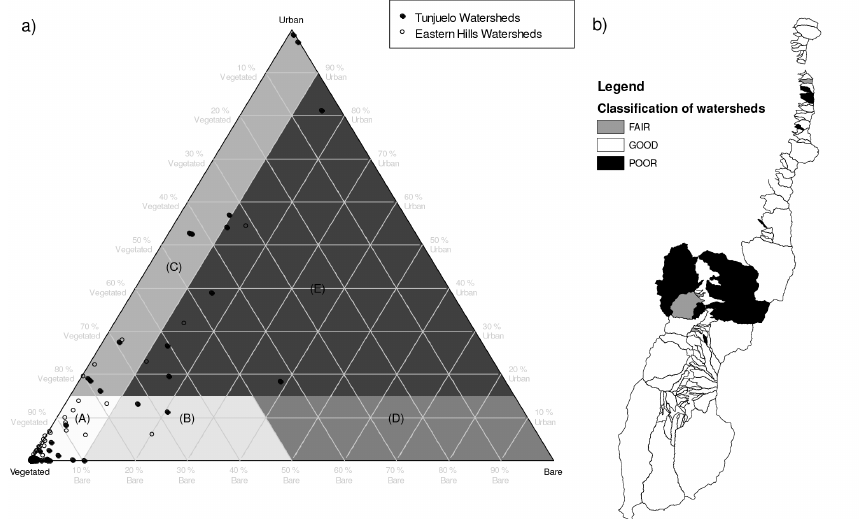
Figure 10. (a) Ternary plot for classification of watersheds according to land cover. The description of the zones of the plot is as follows: (A) low percentage bare soil, low percentage of urban soil and high percentage of vegetated areas; (B) high percentage of bare soil, low percentage of urban soil and high percentage of vegetated areas; (C) low percentage of bare soil, high percentage of urban land and low percentage of vegetated areas; (D) high percentage of bare soil, low percentage or urban soil and low percentage of vegetated land; (D) high percentage of bare soil, high percentage of urban area and low percentage of vegetated cover. (b) Classification of watersheds according to land cover.